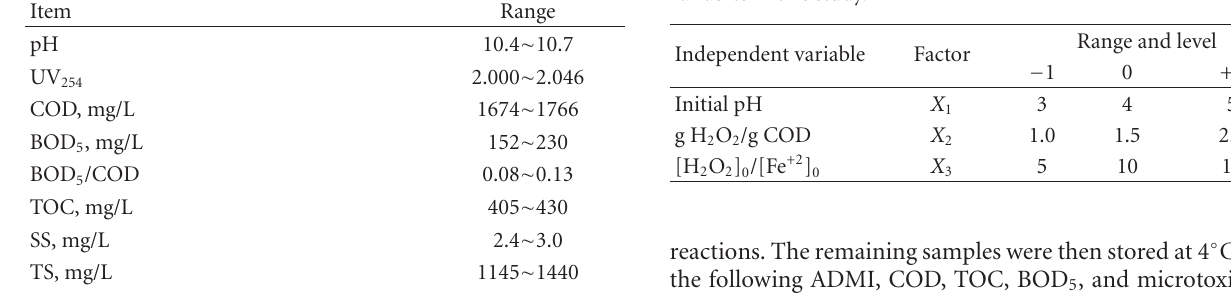
Table 1: Characteristics of color filter wastewater. Table 2: Experimental range and levels of the process independent variables in this